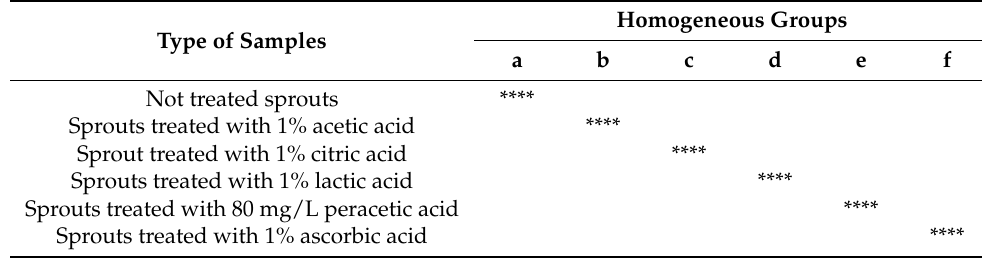
Table 6. Group homogeneity test ( α = 0.05) comparing the effect of the organic acids used on the antioxidant properties (ABTS) of red cabbage sprouts subjected to 14-day